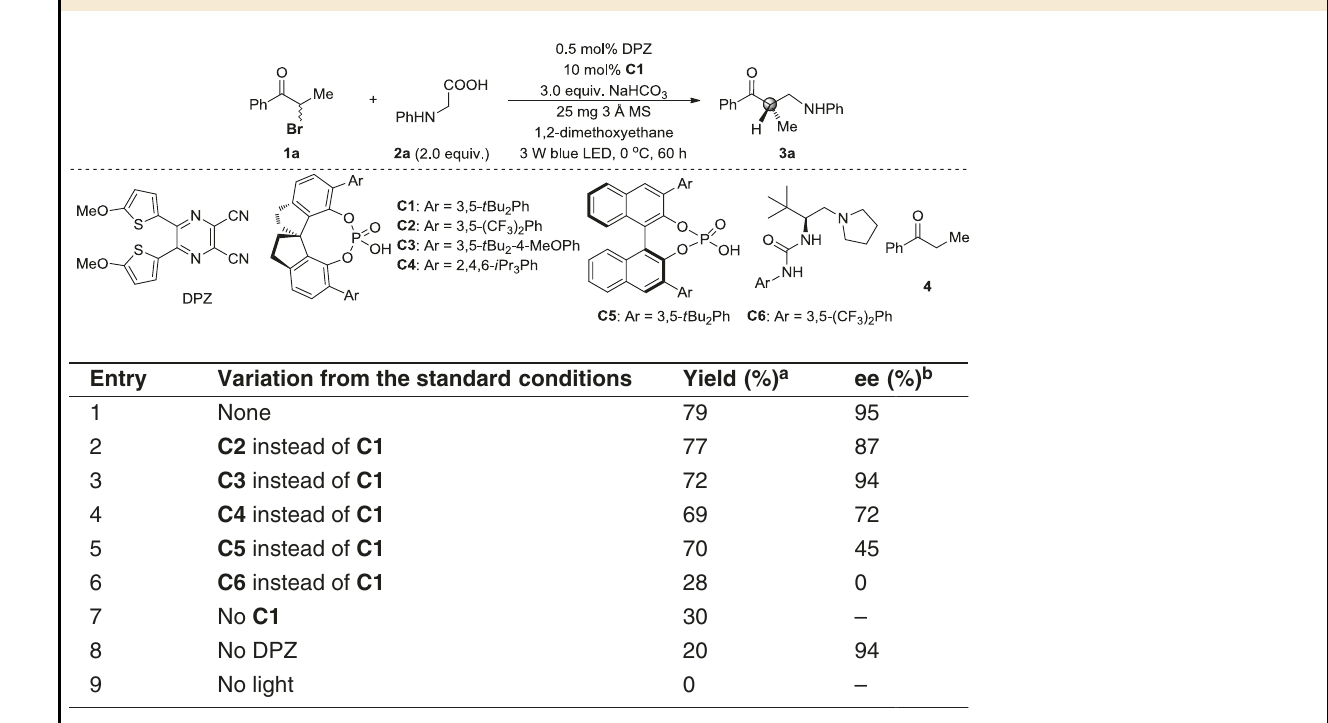
Table 1 Optimization of reaction